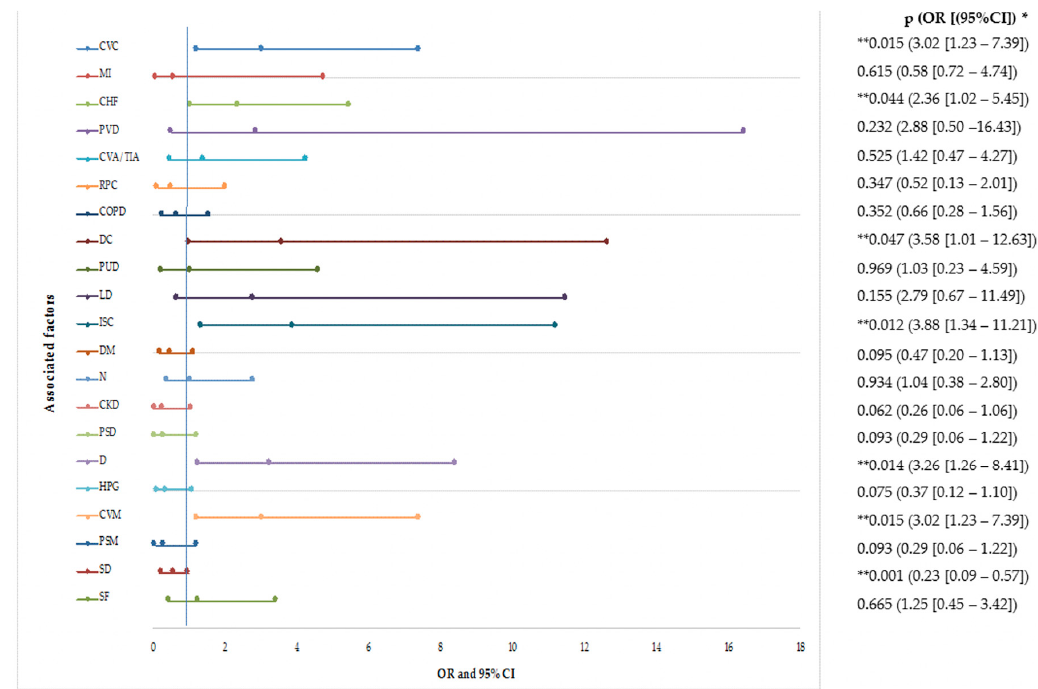
Figure 4. Forest plots of the associated factors with recurrent CDI (logistic regression analysis). *